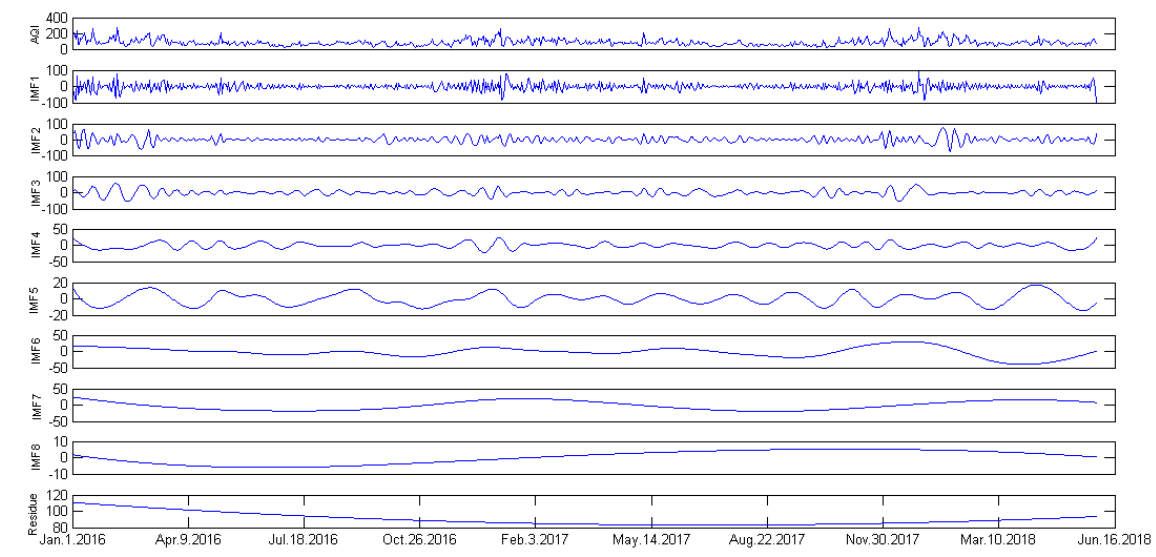
Figure 3. Data decomposition results of AQI in Hefei.